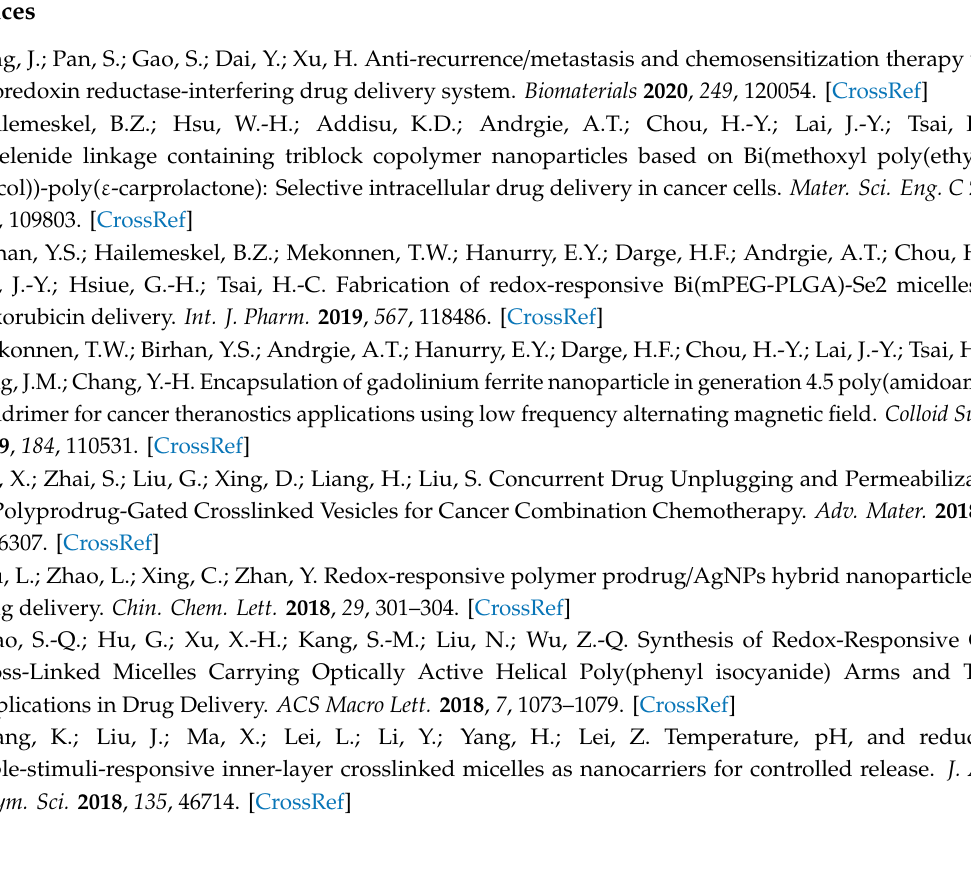
s1, Figure S1: 1 H NMR spectrum of BLA-NCA in DMSO-d 6 , Figure S2: (A) FTIR spectra of mPEG-PBLA, (B) mPEG-PBLA-PCL, (C) mPEG-PLA-PCL and (D) mPEG-P(LA-DSeDEA)-PCL, Figure S3: 13 C NMR spectra of mPEG-P(LA-DSeDEA)-PCL in CF 3 COOD, Figure S4: (A) Particle size distribution of NCMs, (B) DOX@NCMs and (C) DOX@CCMs, Figure S5: (A) Colloidal stability of blank and (B) DOX-loaded micelles incubated with BSA; (C) micellar size distribution against 10-fold DMF, Figure S6: (A) Fluorescent emission spectra of RhB@CCMs incubated with PBS and (B) 0.1% H 2 O 2 for 72 h; (C) redox stimuli triggered CCMs swelling in the presence of 10 mM GSH and 0.1% H 2 O 2 , Figure S7: (A) Absorbance of DOX, (B) the calibration curve for serial concentrations of free DOX; (C) the absorbance of DOX@NCMs and (D) DOX@CCMs, Figure S8: (A) IC 50 value of DOX in HaCaT, (B) MDCK, and (C) HeLa cells treated with free DOX, DOX@NCMs, and DOX@CCMs for 24 h (n = 3), Figure S9: Fluorescence microscope images of HaCaT cells incubated with 3 µ g / mL DOX, DOX@CCMs, and DOX@NCMs for 3 and 9 h. The sale bar is 20 µ